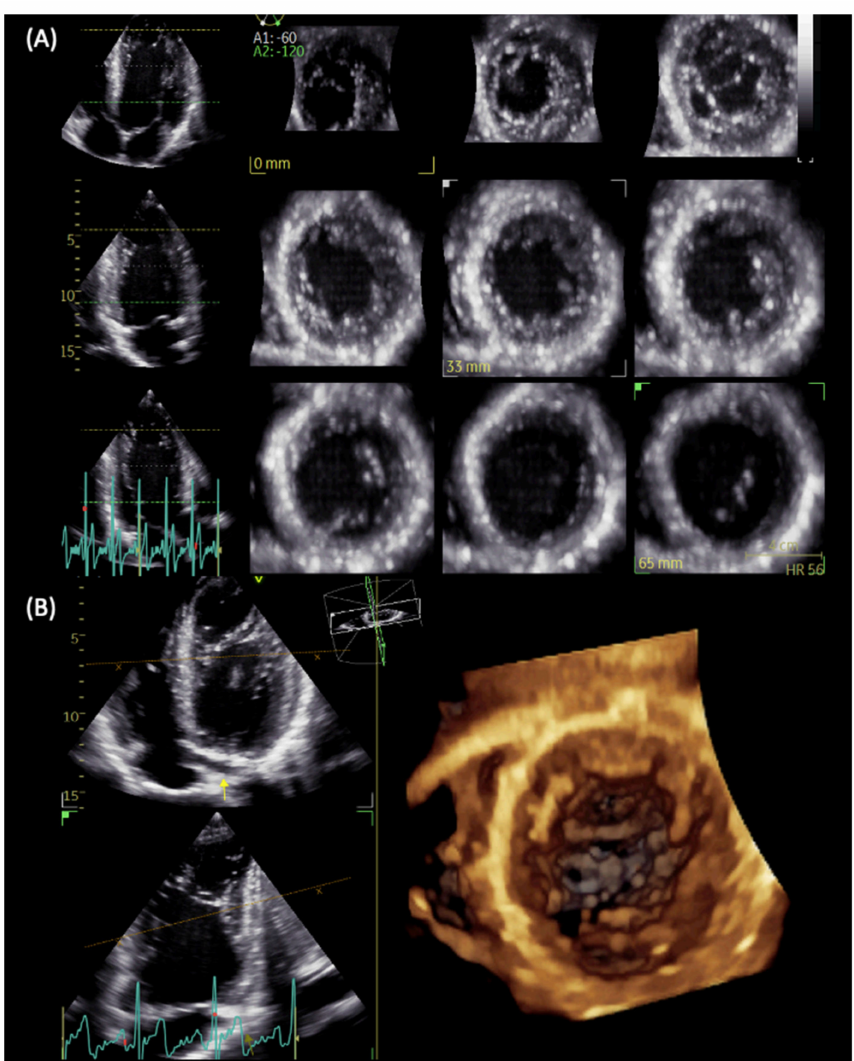
Figure 3. LVNC in a patient with repaired aortic coarctation. Three-dimensional echocardiography with full-volume acquisition allows the better visualization of multiple apical intertrabecular recesses with multislice ( A ) and 3D reconstructions ( B